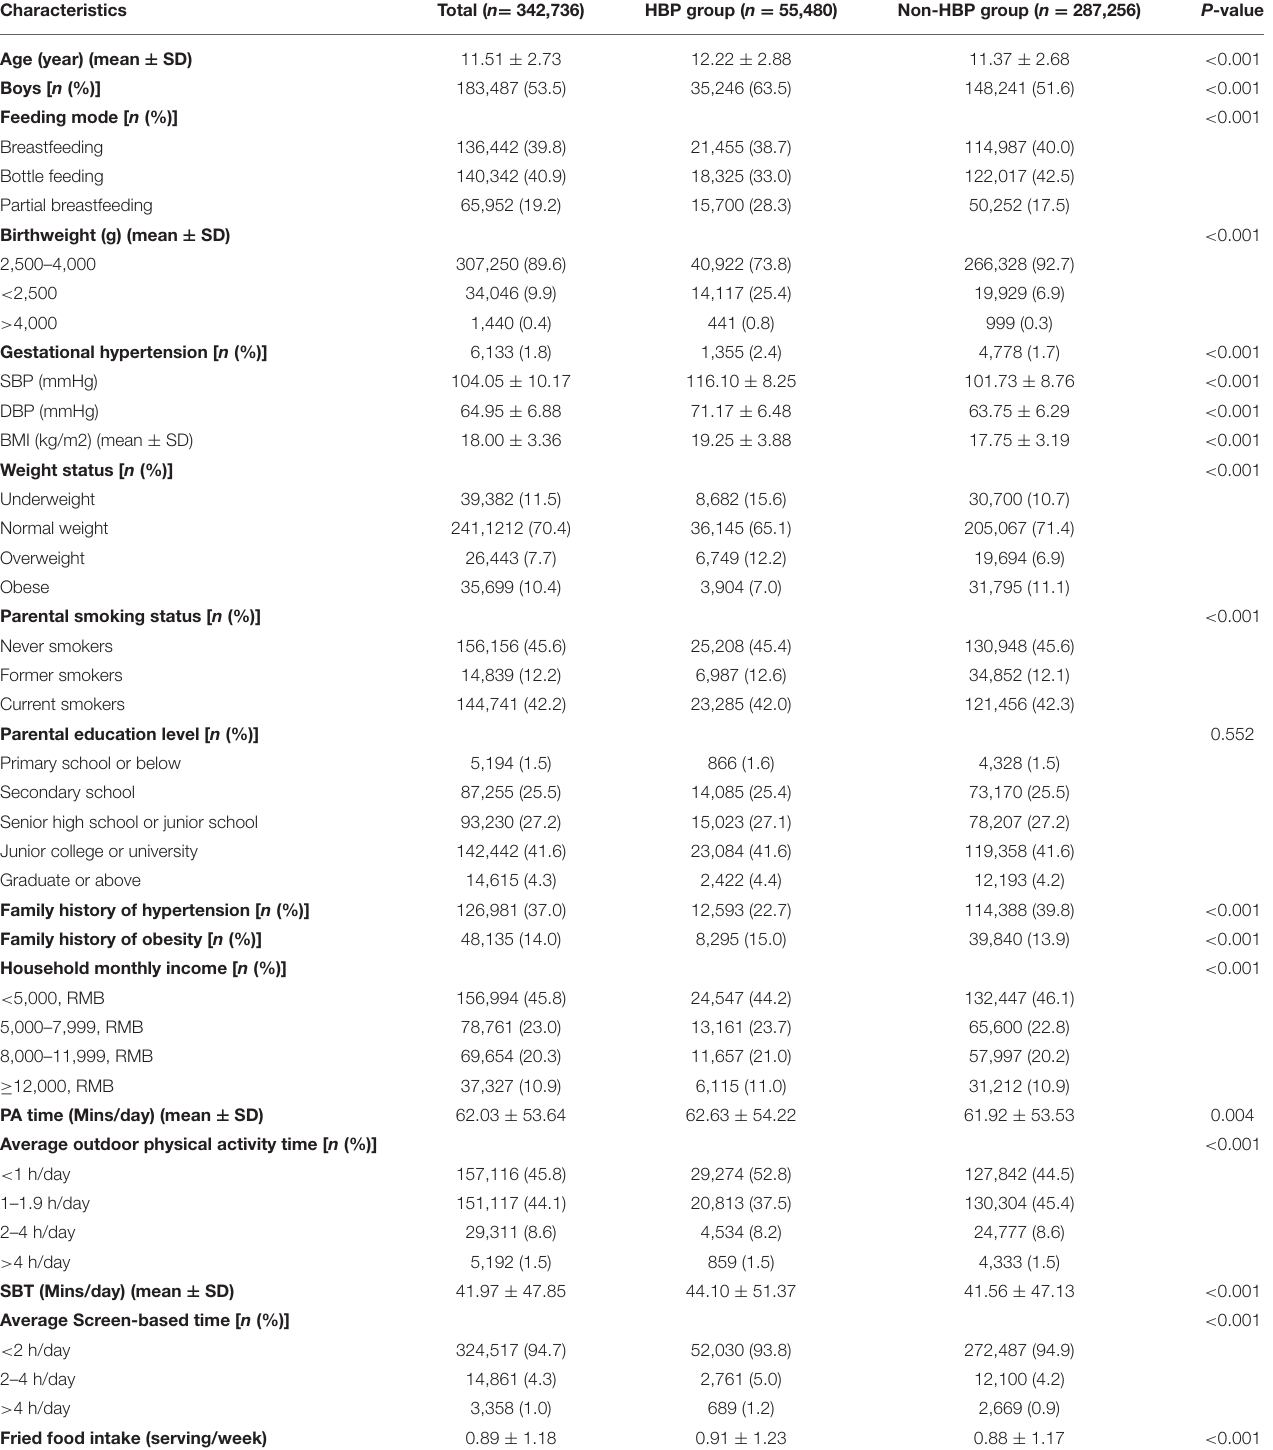
TABLE 1 | Comparison of baseline characteristics between HBP group and non-HBP group.